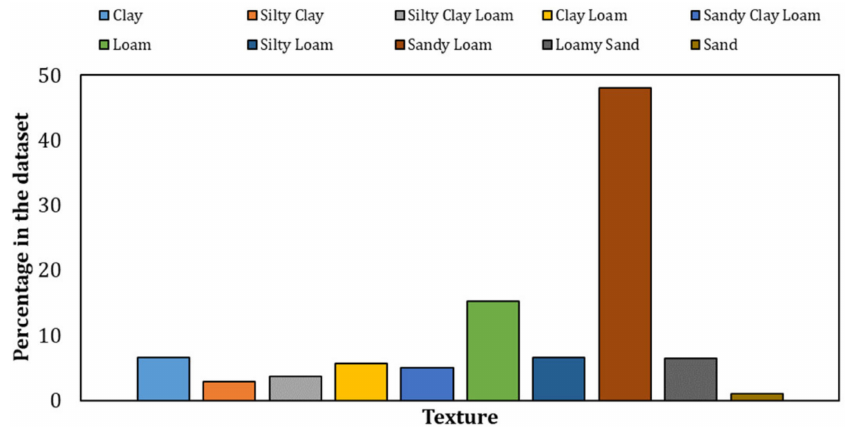
Figure 4. Training dataset composition with reference to soil